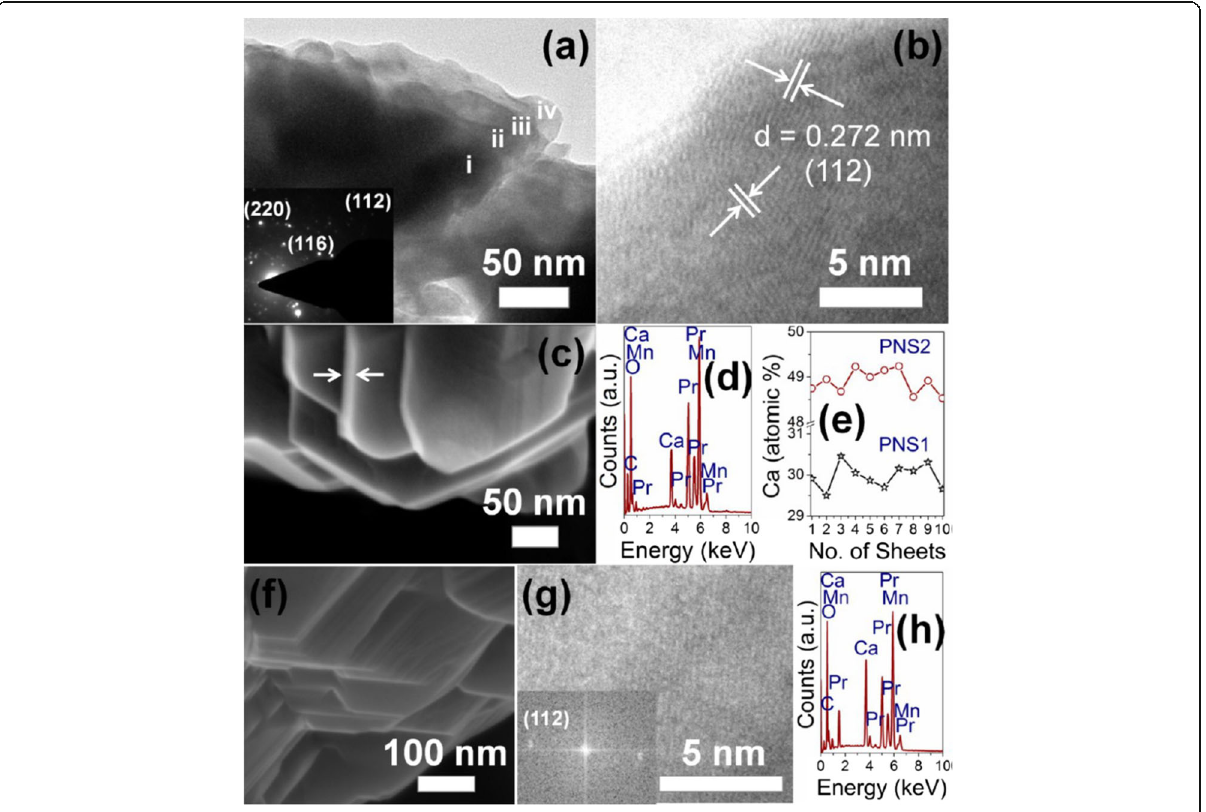
Fig. 14 a TEM image of Pr 0.7 Ca 0.3 MnO 3 nanosheet (PNS-1 sample). i – iv represent four stacked nanosheets. Inset is the SAED pattern. b HRTEM image of two nanosheets oriented in different directions. c FE-SEM image of PNS-1. Arrows indicate the thickness of the nanosheet. d EDAX pattern of PNS-1. e Homogeneity profile of Ca 2+ doping on ten nanosheets in PNS1 and PNS2 samples. f FE-SEM, g TEM (inset: FFT), and h EDAX pattern of Pr 0.51 Ca 0.49 MnO 3 nanosheet (PNS-2 sample). Reproduced with permission of